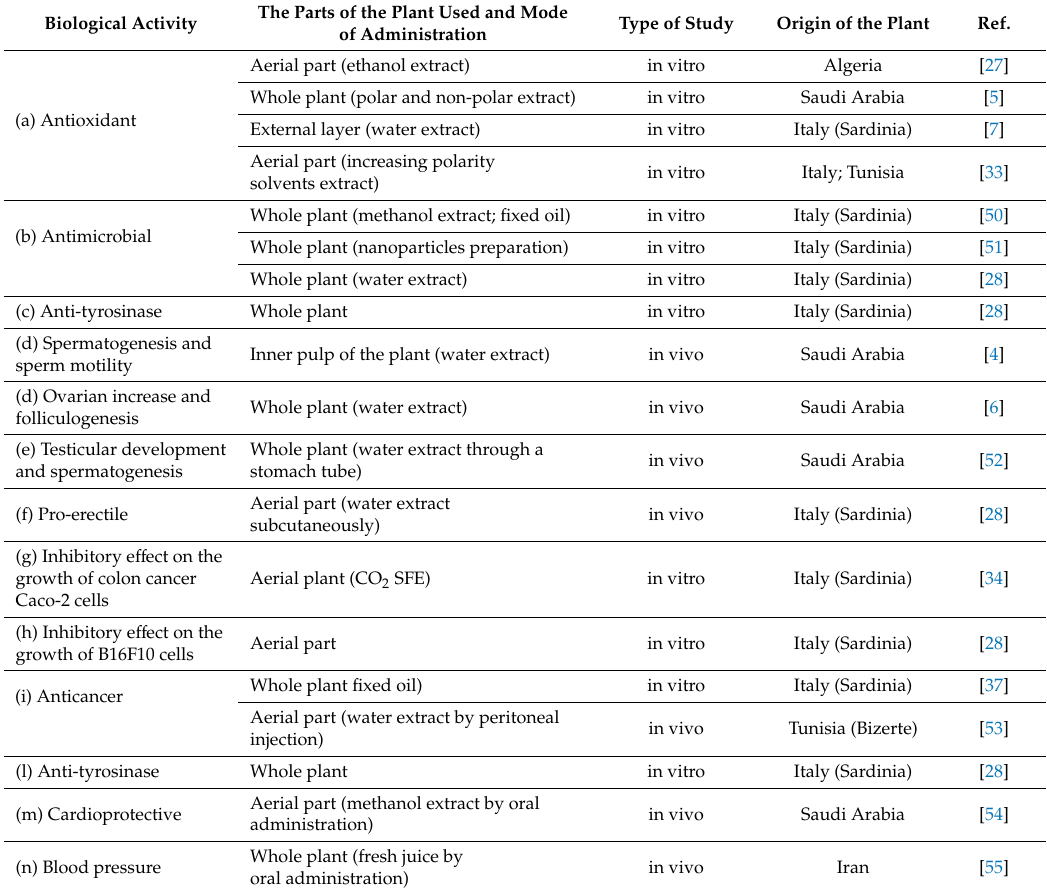
Table 4. Main biological activities reported in C. coccineum